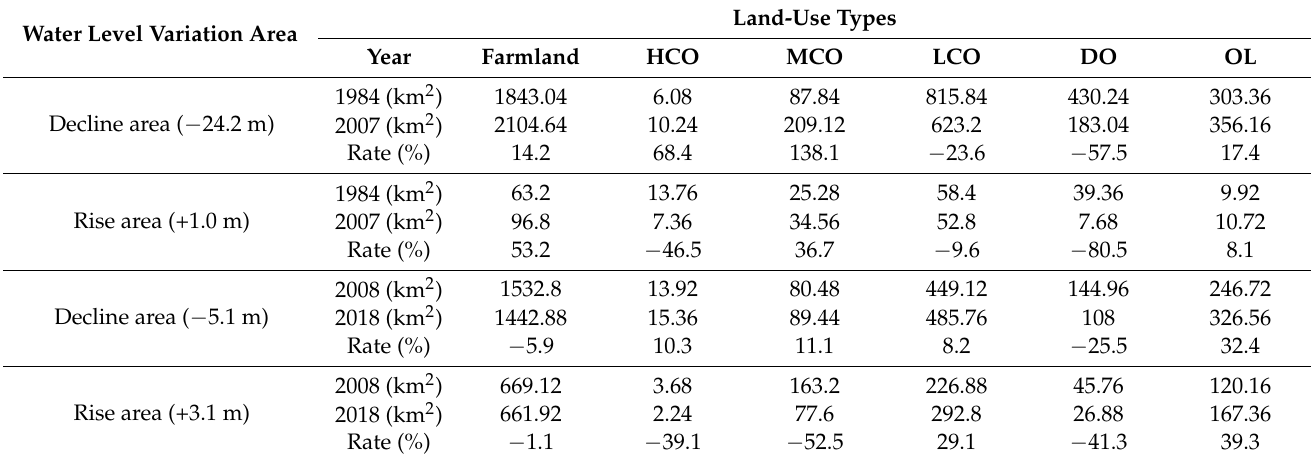
Table 3. Land use changes in various groundwater depth zones from 1984 to